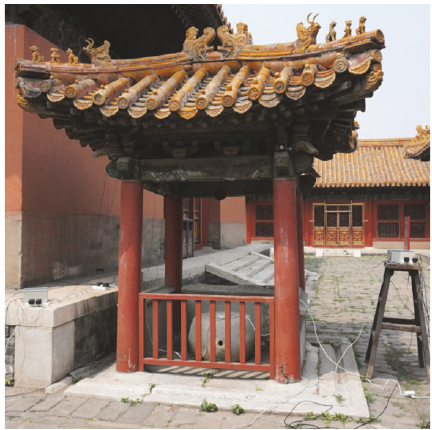
Figure 10: Traditional timber pavilion in the Forbidden City.